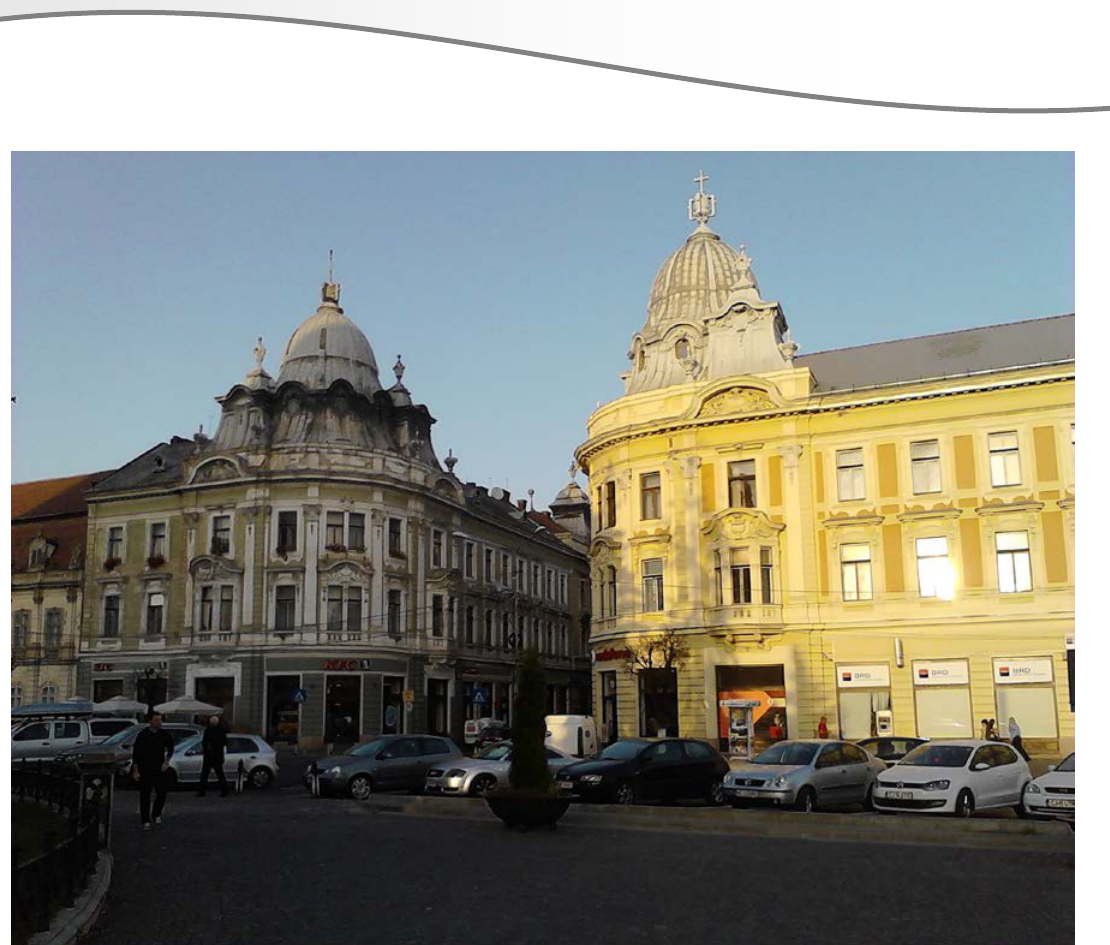
Figure 18: Old hybrid cultural landscape in the Union Sqaure – The “Twin” Baroque eclectic style buildings of the Roman-Catholic Statuses having commercial façade on their ground floor